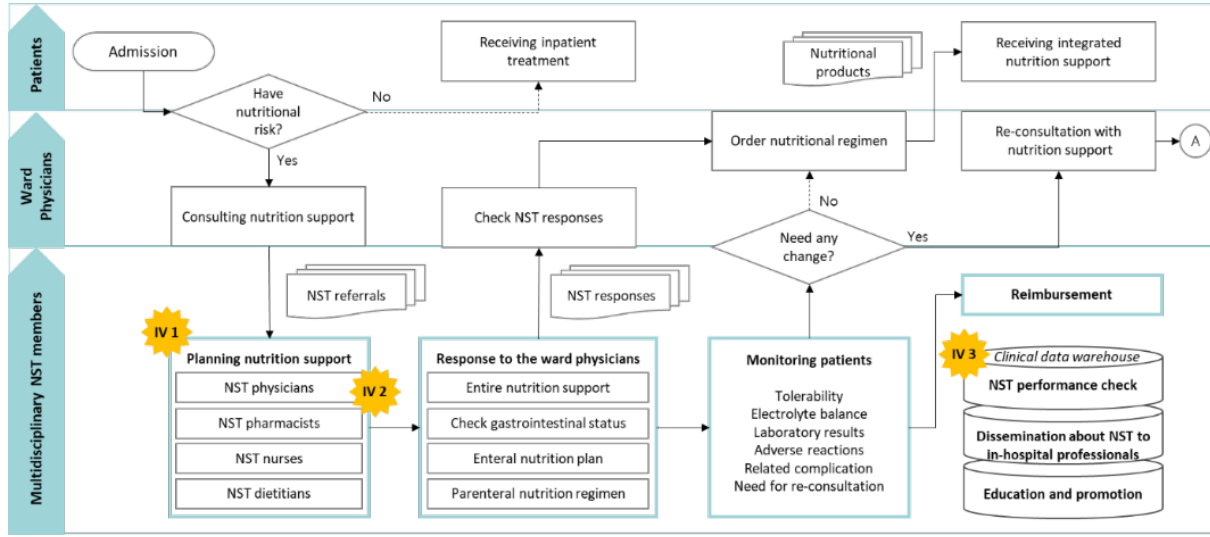
Figure 1. Nutrition support process by the multidisciplinary nutrition support team (NST) at Seoul National University Bundang Hospital: Intervention ( IV 1 ), NST patient management program establishment; ( IV 2 ) upgrade of NST attending physicians’ response steps; ( IV 3 ) construction of clinical data warehouse.